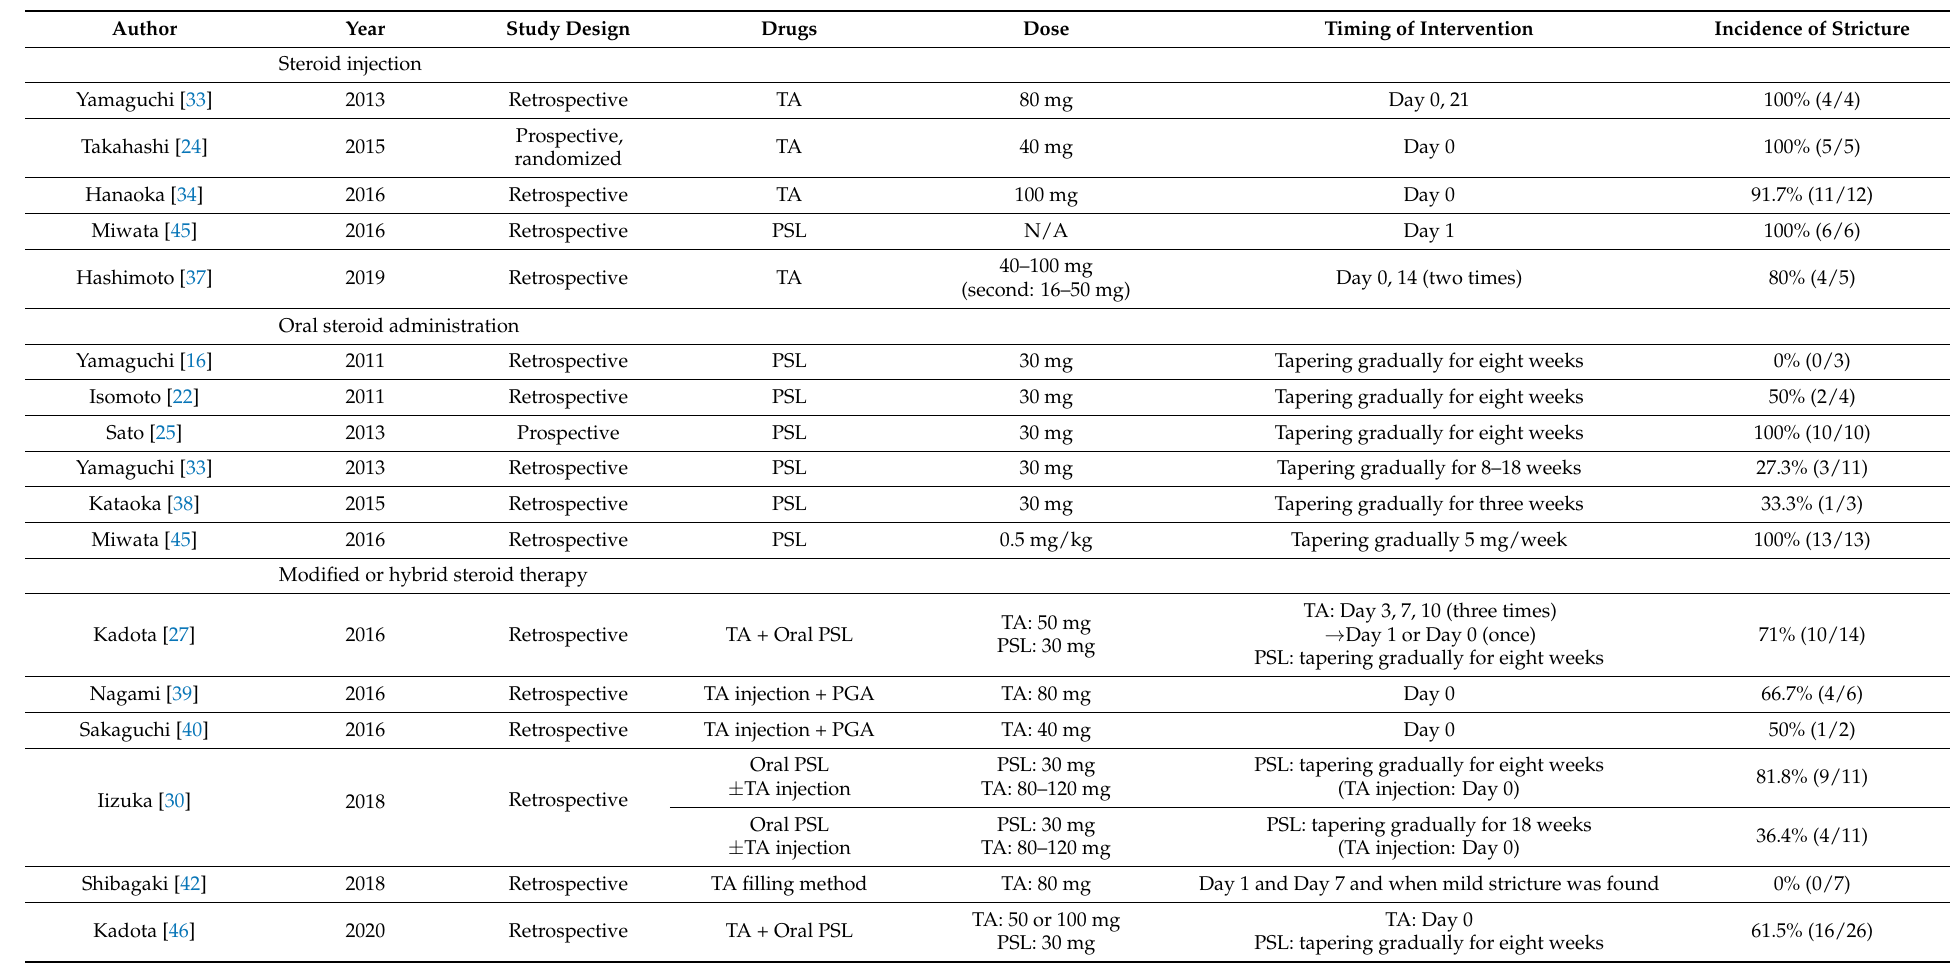
Table 4. Effect of preventive steroid therapy after total circumferential endoscopic submucosal dissection for esophageal squamous cell